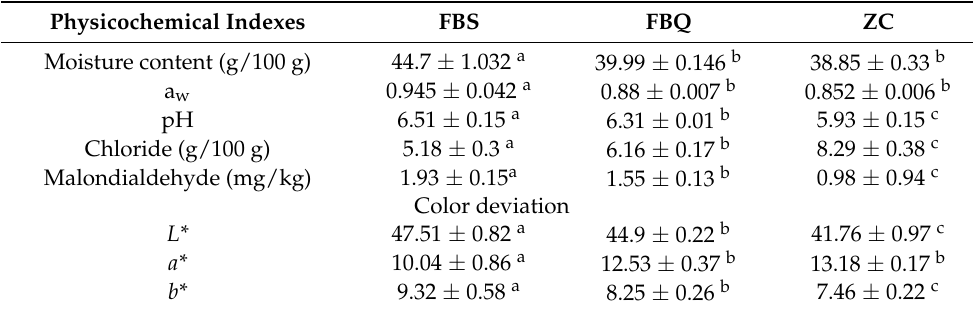
Table 1. Physicochemical characteristics of normal and spoiled Mianning hams. Physicochemical